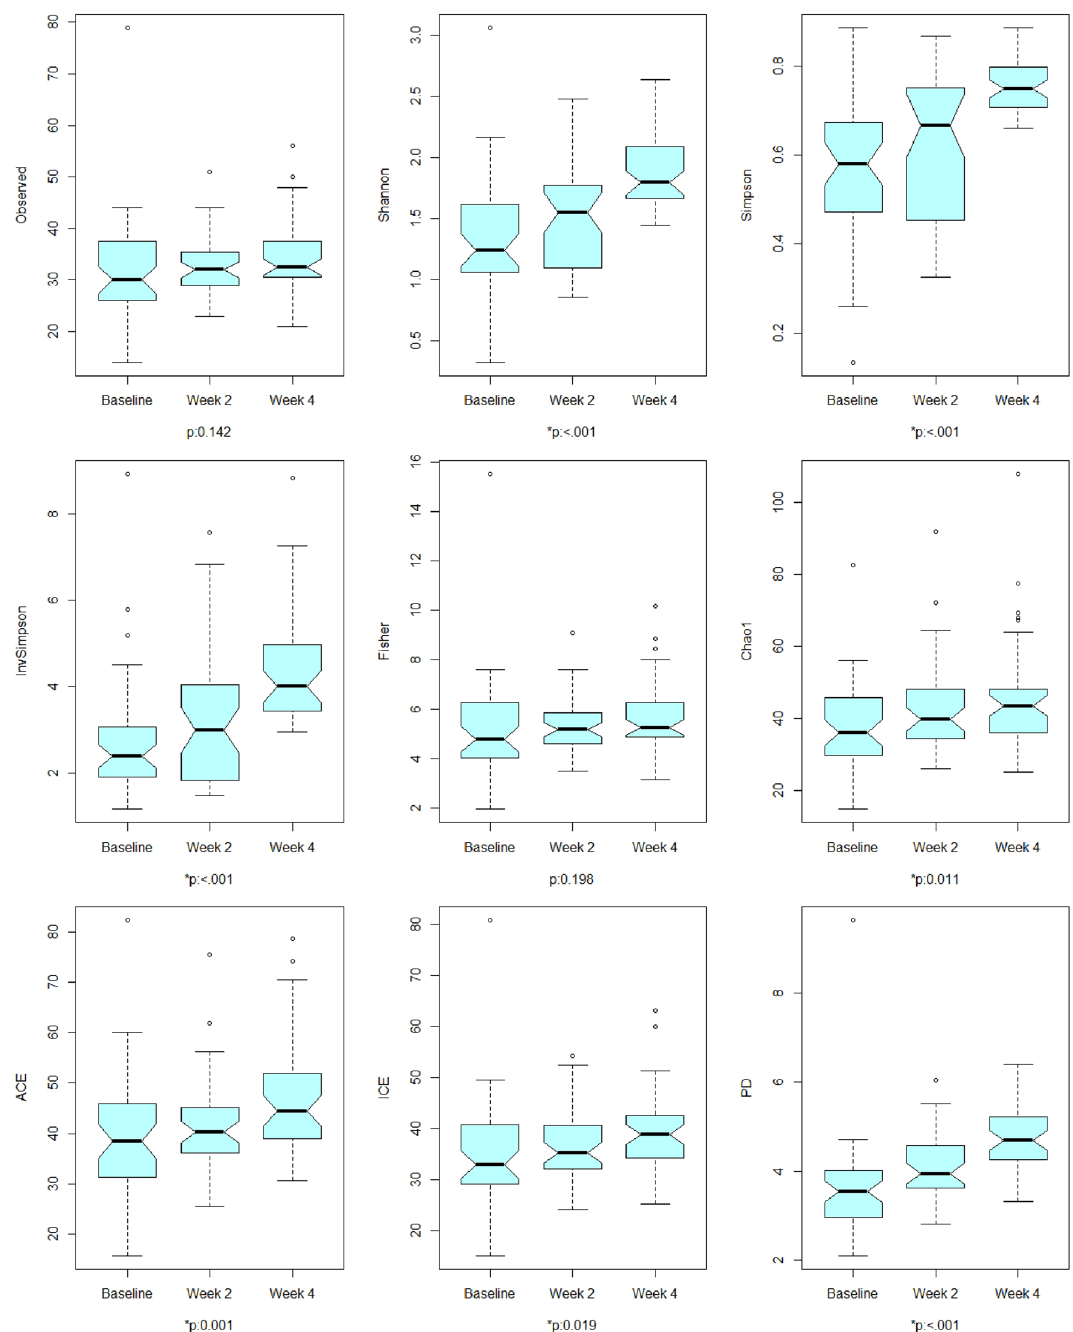
Figure 3. The results for comparitive analysis in alpha-diversity (global test). The p-values were calculated using LRT based on LMM for global testing to see if all groups have the same distribution in each alpha-diversity index ( H 0 ) or if at least one group has a different distribution in each alpha-diversity index ( H 0 ). *p represents statistical significance at the level of